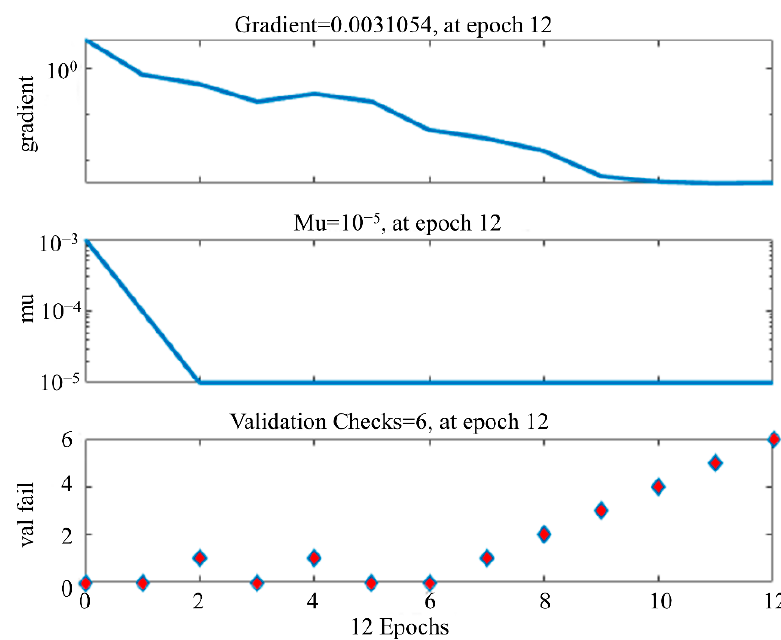
Figure 6. LM algorithm training process.